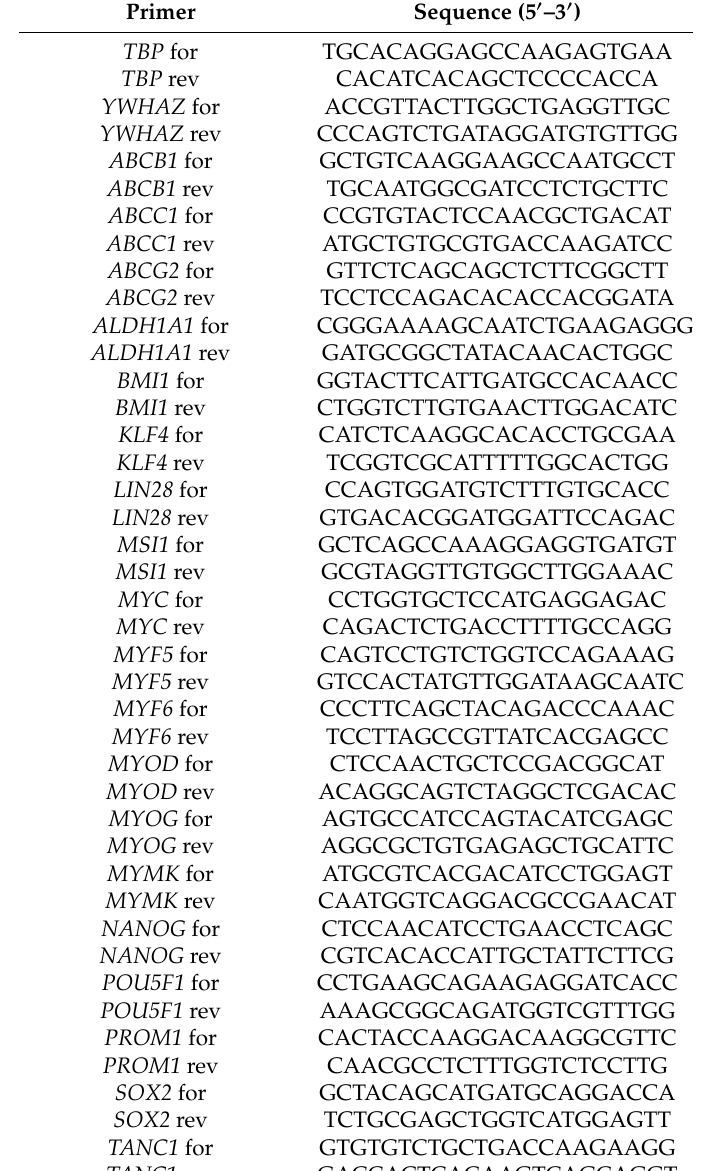
Table 1. Quantitative real time PCR (RT-PCR) primer sequences. Primer Sequence (5 (cid:48) –3 (cid:48)